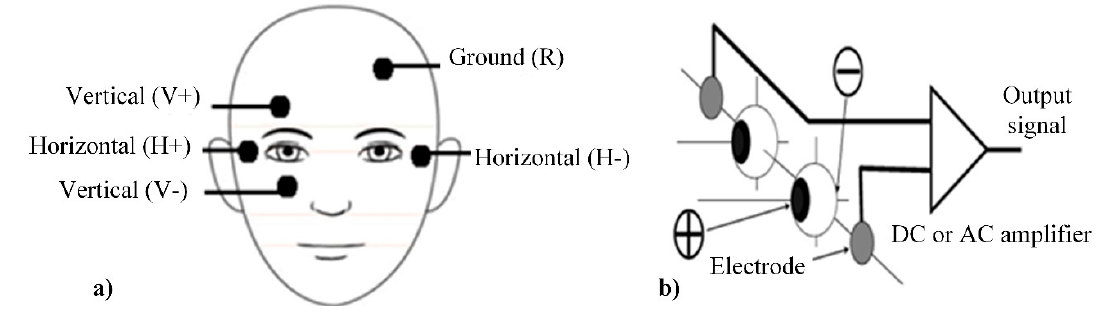
Figure 13. Principle of electrooculography (EOG): ( a ) electrode placement scheme [160]; ( b ) measurement principle [161].